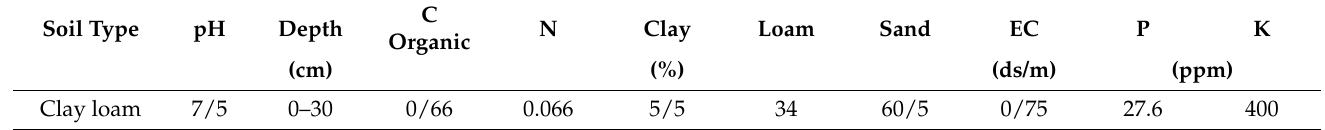
Table 1. Physico-chemical characteristics of Soil.